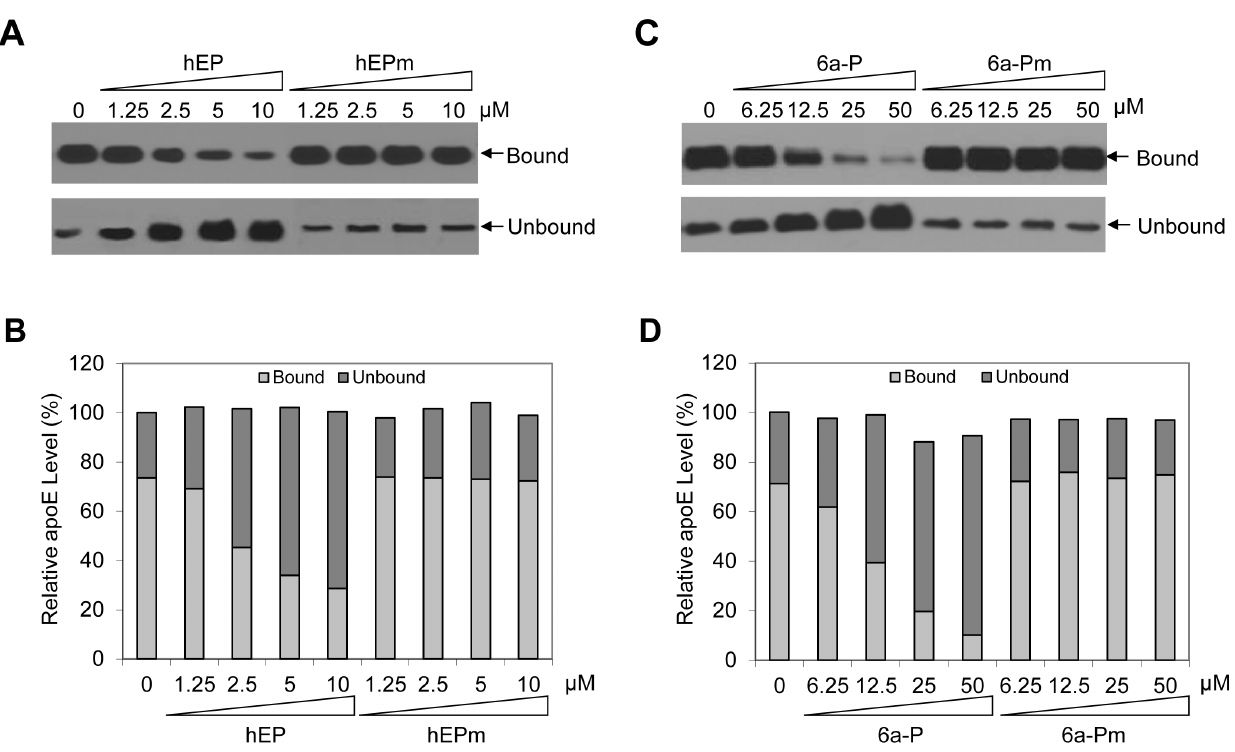
Figure 5. Effects of the apoE-derived peptides and the HSPG-binding peptide 6a-P on heparin binding. Heparin-immobilized beads (Pierce) were pre-equilibrated with PBS and then incubated with 500 m l of Huh-7.5 cell culture medium in the absence or presence of varying concentrations of the peptide hEP or 6a-P. The mutant peptides hEPm and 6a-Pm were used as controls. After 2 hrs incubation at room temperature, apoE-bound heparin-immobilized beads were spun down by centrifugation. The supernatant was collected and used for detection of the unbound apoE. The apoE-bound beads in pellet were washed three times with 1 ml of PBS. The heparin-bound and unbound apoE proteins were measured by Western blotting using an apoE-specific monoclonal antibody